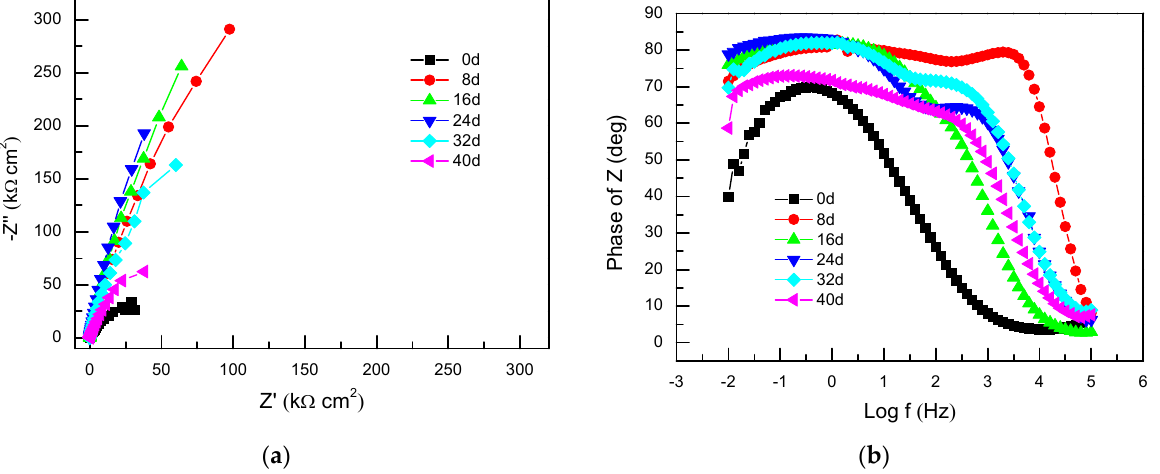
Figure 4. EIS results of S32750 after exposure at different times in the simulated marine atmosphere: ( a ) Nyquist plots and ( b ) Bode plots.